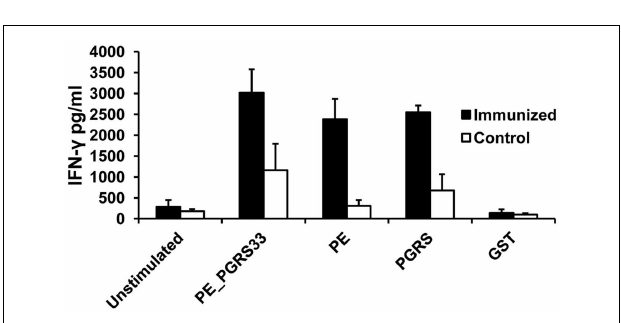
FIGURE 3 |Antigen-specific IFN- γ secretion in immunized mice. Spleen cells from mice immunized with PE_PGRS33 or from control mice were incubated with 25 µ g of PE_PGRS33, PGRS, PE, or GST recombinant purified proteins plus 10 µ g/ml of polymyxin B for 4days.The culture supernatants were evaluated for IFN- γ production using ELISA assay. Each bar represents the mean ± SD of data from four mice per group. Representative results of three independent experiments are